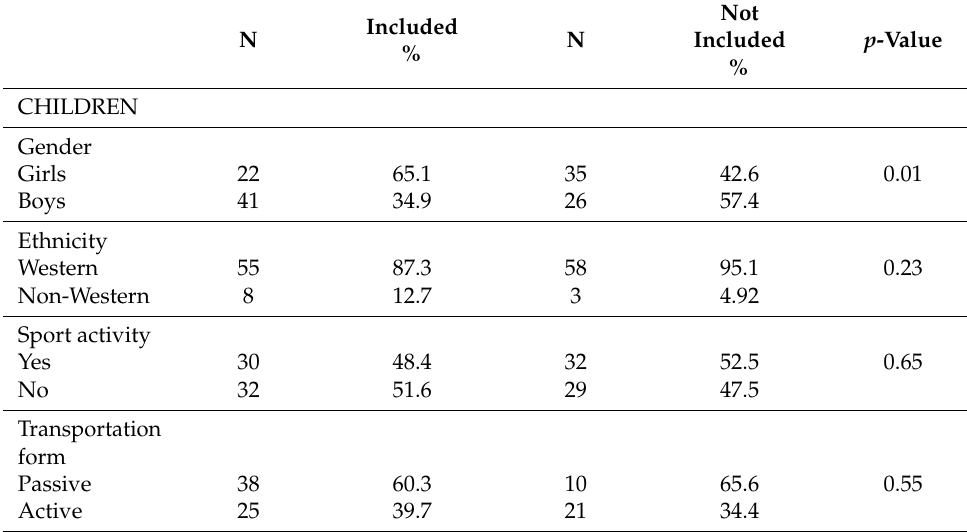
Table 3. Comparison of children included and children not included in this